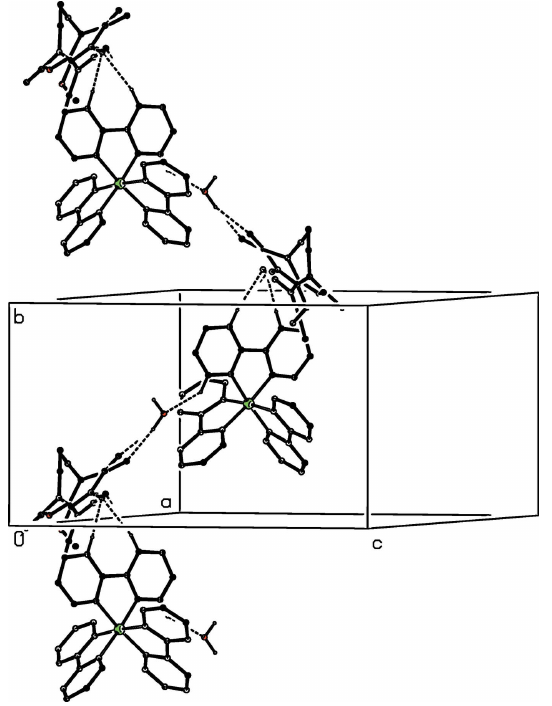
Figure 7 Part of the crystal structure of compound (I) showing the formation of a hydrogen-bonded chain running parallel to the [010] direction. For the sake of clarity, the type 1 anion and the H atoms not involved in the motif shown have been omitted.